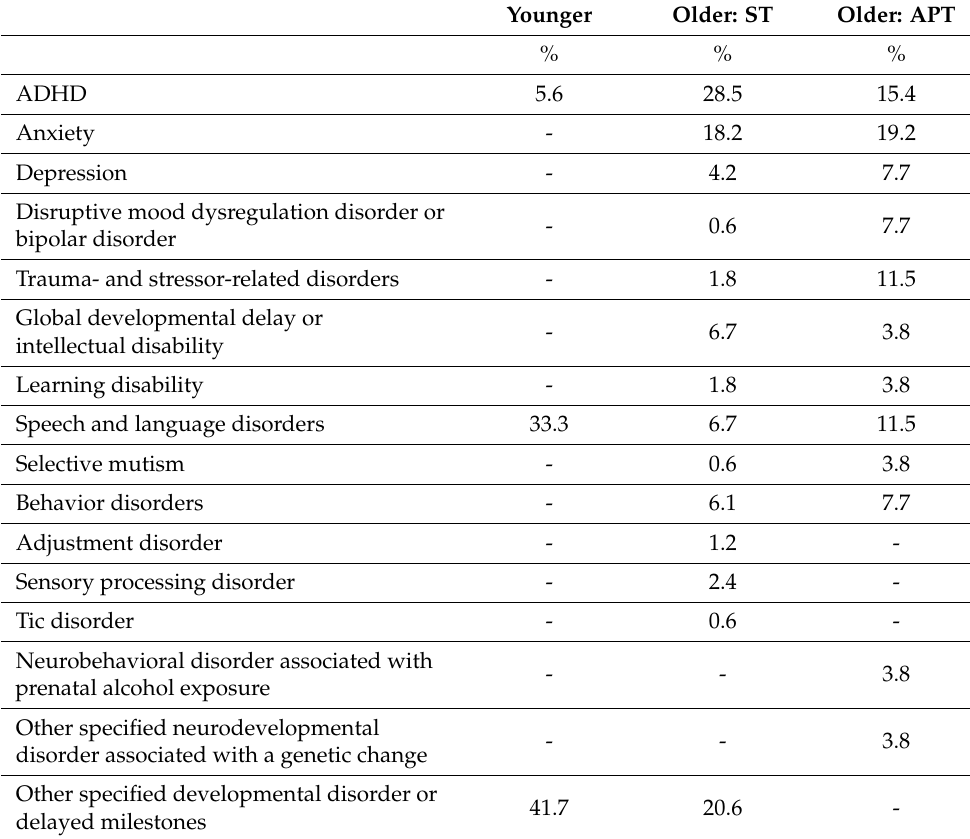
Table 2. “No ASD” diagnoses provided or maintained by history, listing diagnoses provided in the cases where ASD was not diagnosed. Diagnoses were not mutually exclusive, as patients could receive more than one